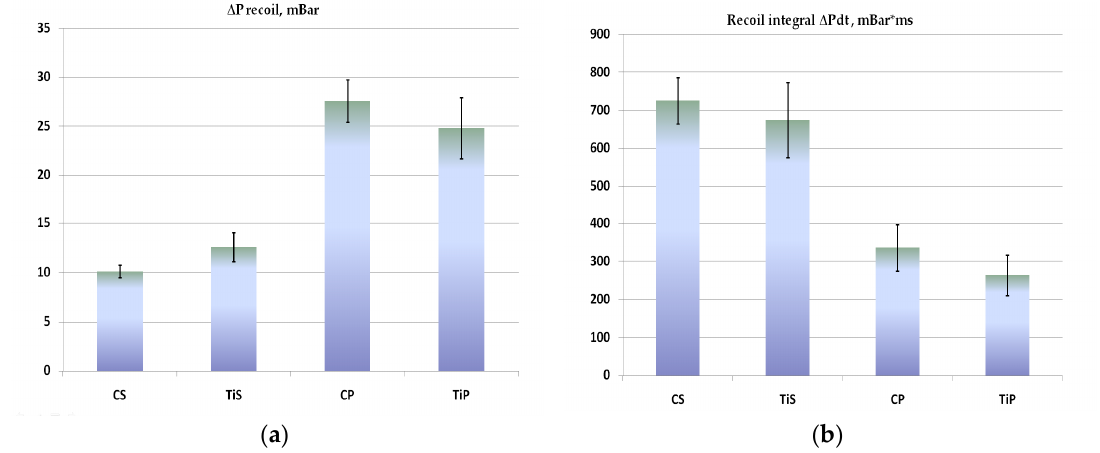
Figure 4. ( a ) Butt pressure peak values Pa, and ( b ) pressure change integral Pa(t)*dt during the recoil event averaged for all performed shots. Standing position: original commercial stock (CS), stock made from Ti alloy (TiS); prone position: original commercial stock (CP), stock made from Ti alloy (TiP).